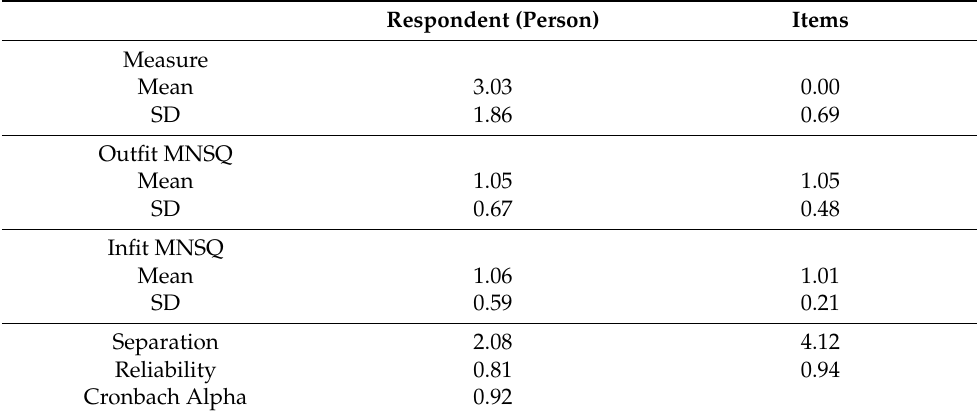
Table 2. Summary statistics for respondents (persons) and items.